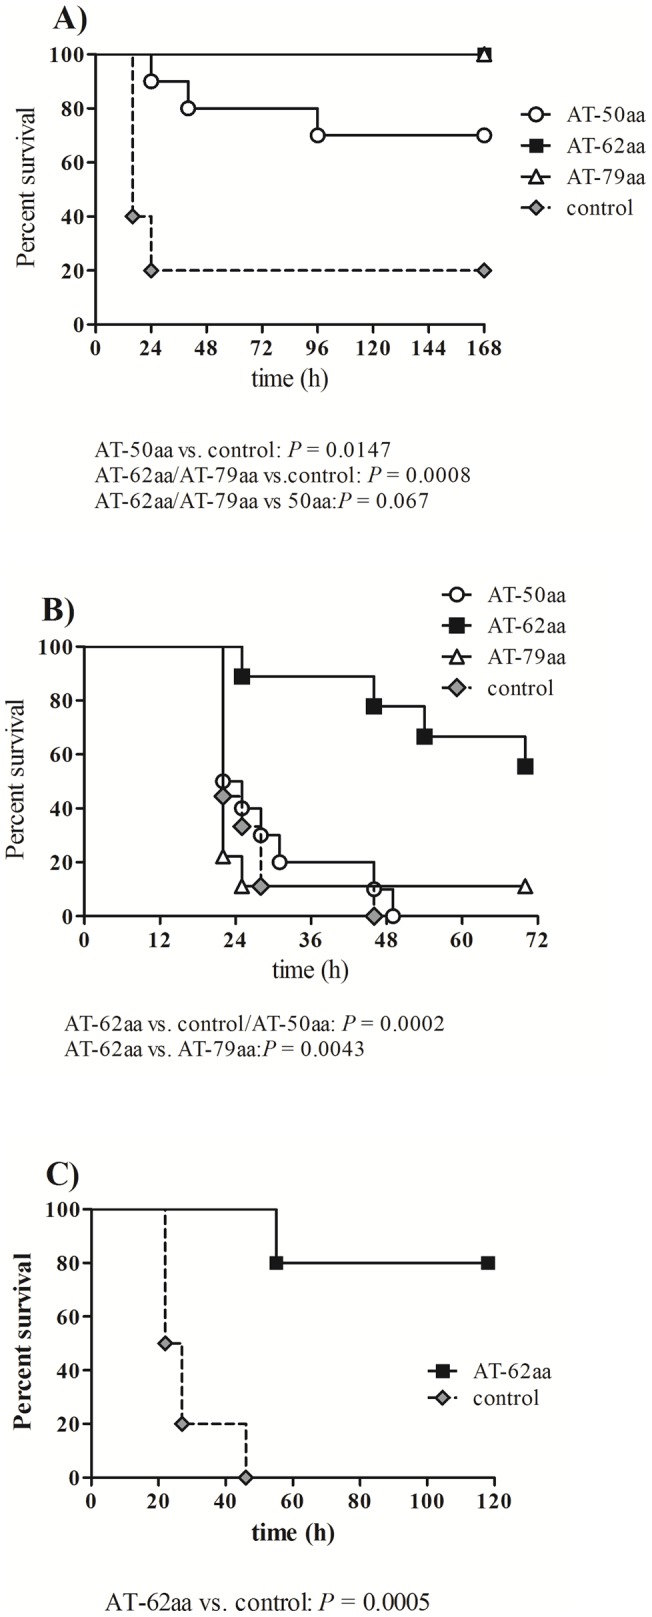
Comparative efficacy study of vaccine candidates in S. aureus bacteremia and pneumonia infection models.Survival of mice vaccinated with the three vaccine candidates and control mice after IP challenge with 5×104 CFU of USA300 along with Hog Mucin (A) or IN challenge with 6×107 CFU of S. aureus strain Newman (B). Survival of mice vaccinated with AT-62aa and challenged IN with 1.5×108 CFU of S. aureus USA300 (C). Symbol key: AT-50aa (open circle), AT-62aa (black square), AT-79aa (open triangles) and mock-immunized mice (grey diamond). Statistical analysis was performed using Log-Rank (Mantel-Cox) test.